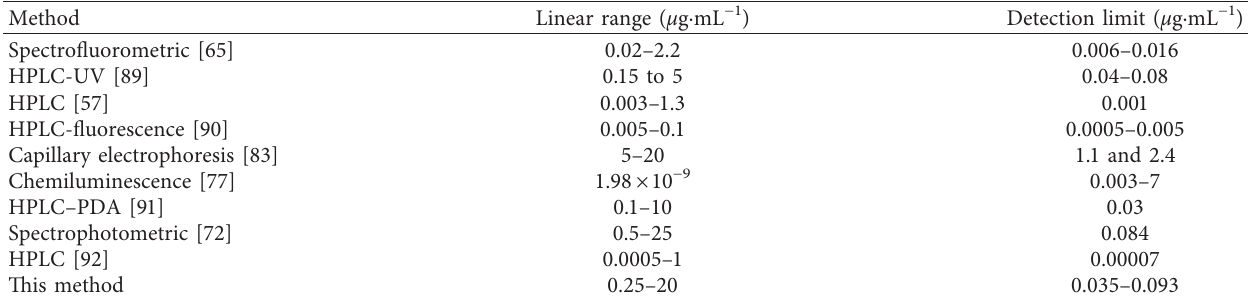
Table 2: Comparison of this method with other reported methods for determination of fluoroquinolones.